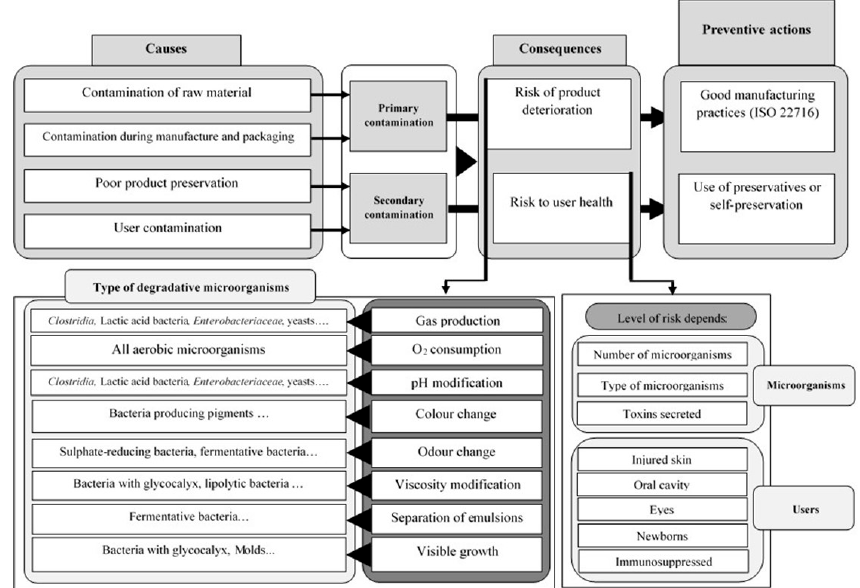
Figure 1. Causes, consequences. and ways of preventing cosmetics contamination